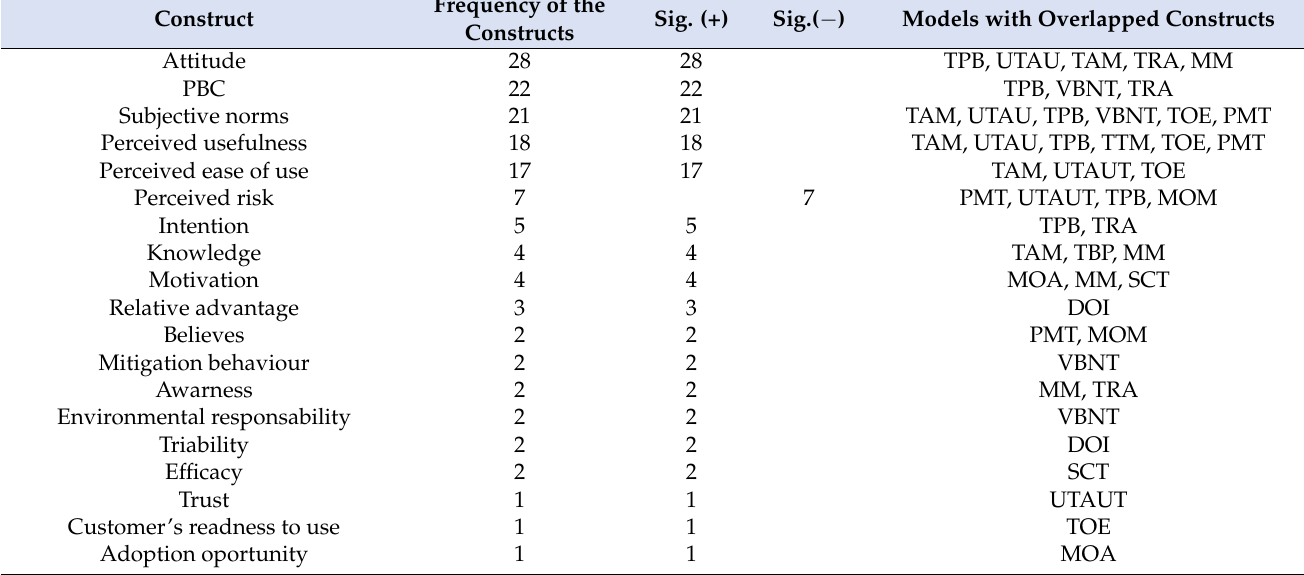
Table 4. Sociopsychological models with overlapping determinants of adoption of sustainability agricultural innovations: results of vote-count